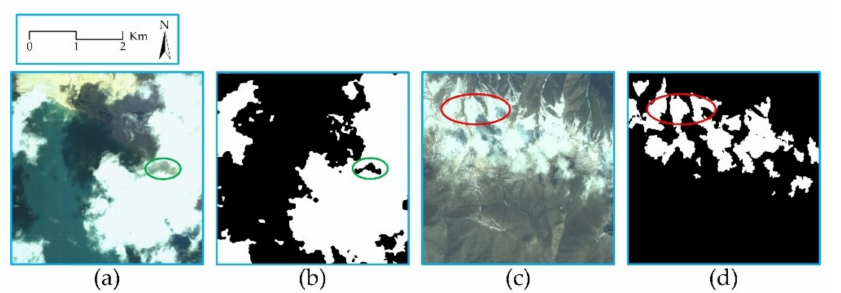
Figure 13. Examples of commission errors and omission errors. ( a ) Image of scene I; ( b ) cloud- detection result of scene I; ( c ) image of scene II; ( d ) cloud-detection result of scene II. The coordinates of ( a ) are 89.3E and 31.4N; ( c ) 103.0E and